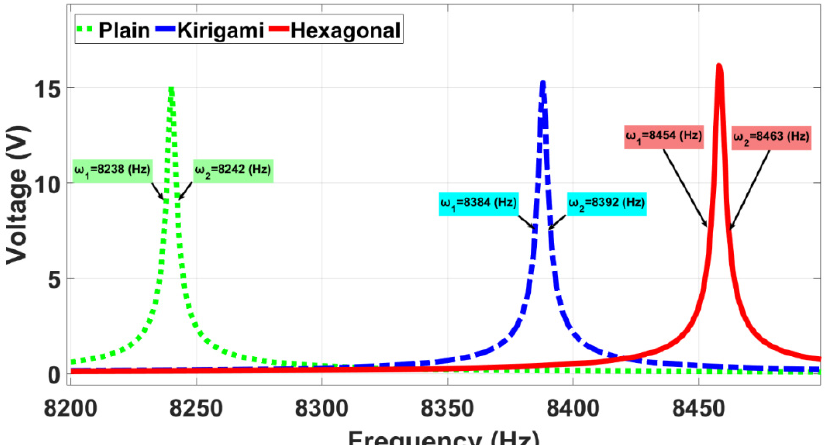
Figure 9. The 3 dB bandwidth indicator.